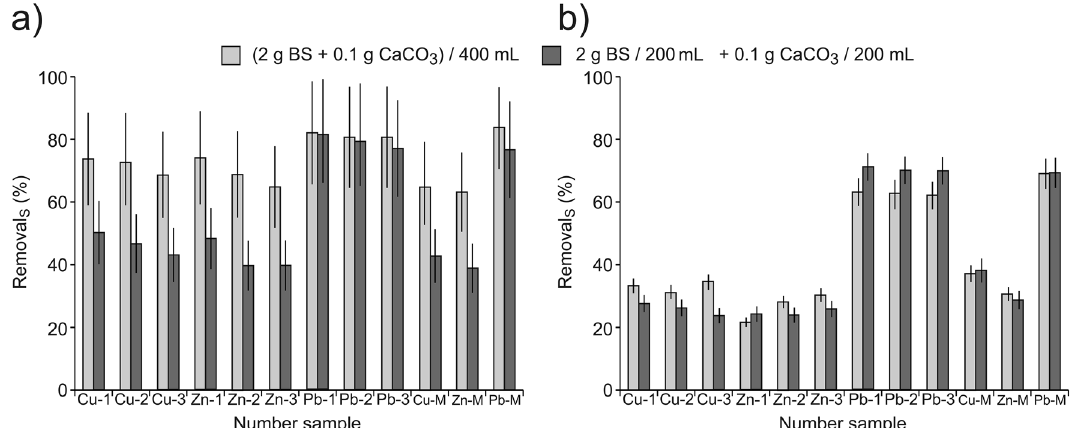
Figure 3. Efficiency of removal metal cations with the use of BS and CaCO 3 , in variants: together light gray and separately dark gray; ( a ) average values for bran from spelt, buckwheat, rice and wheat as well as for BSG, ( b ) for crushed spelt and buckwheat grains.